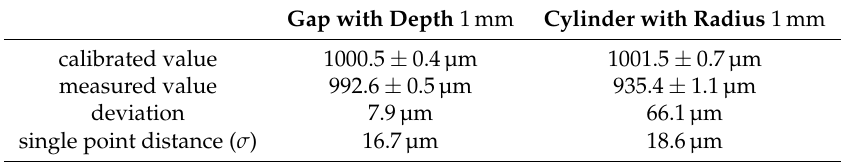
Table 1. Evaluation of a gap with a depth of 1mm and the cylinder with a radius of